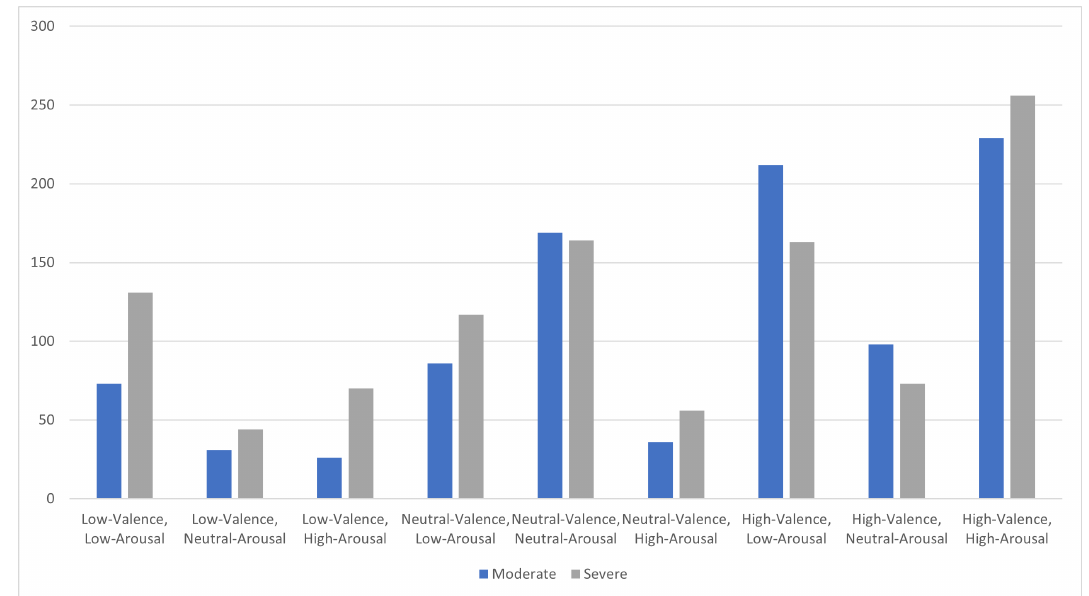
Figure 1. Valence and Arousal frequency grouped by depression severity.